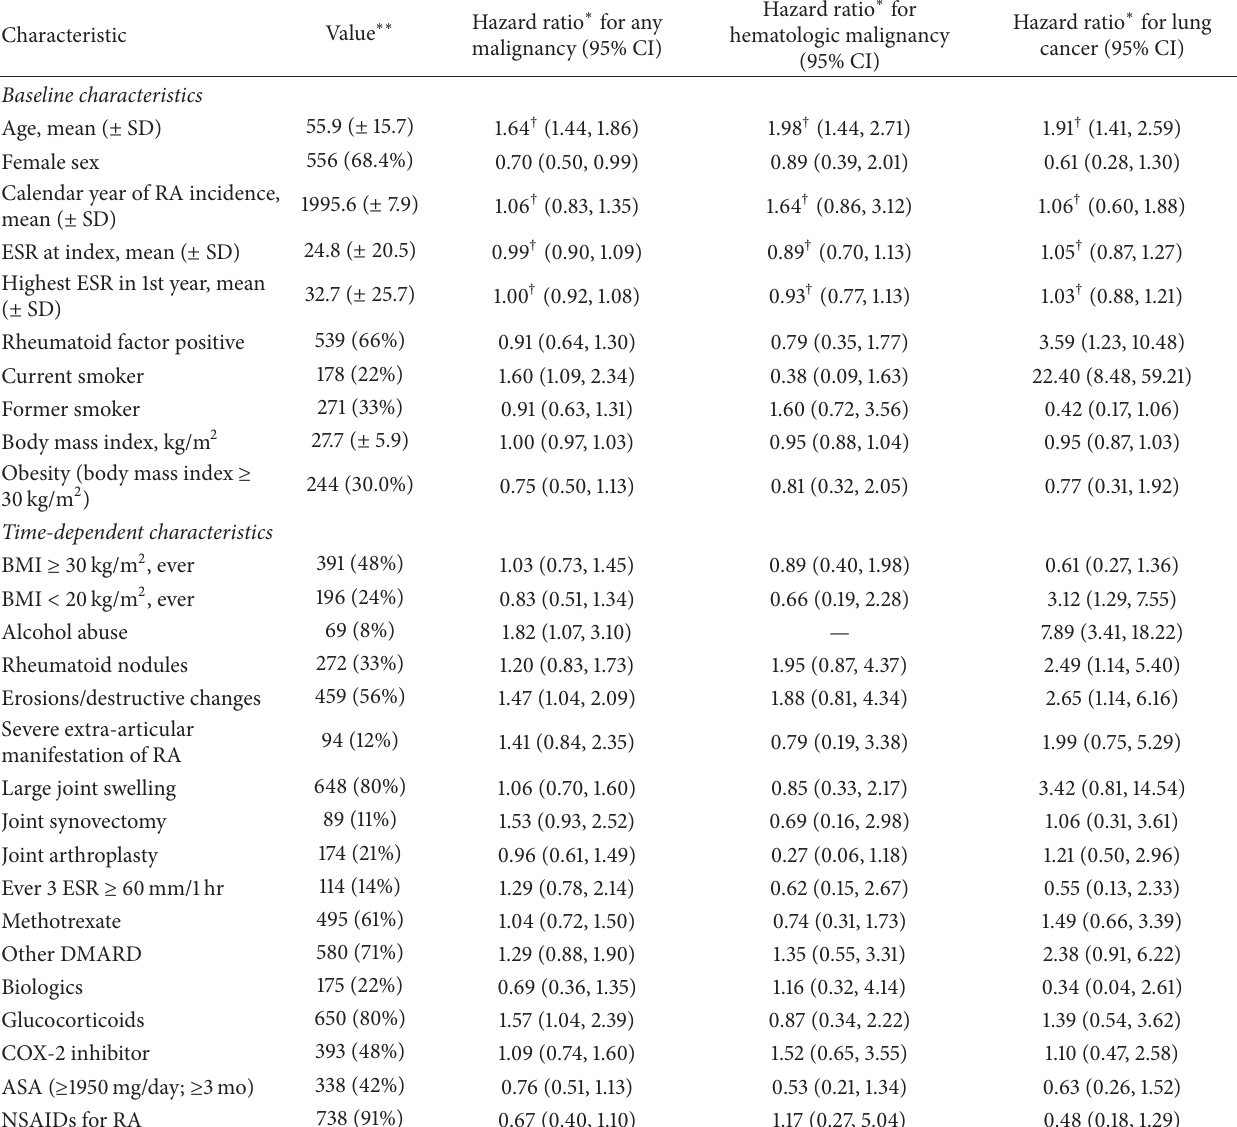
Table 2: Risk factors for malignancy in 813 patients with rheumatoid arthritis (RA) at RA incidence and during follow-up.